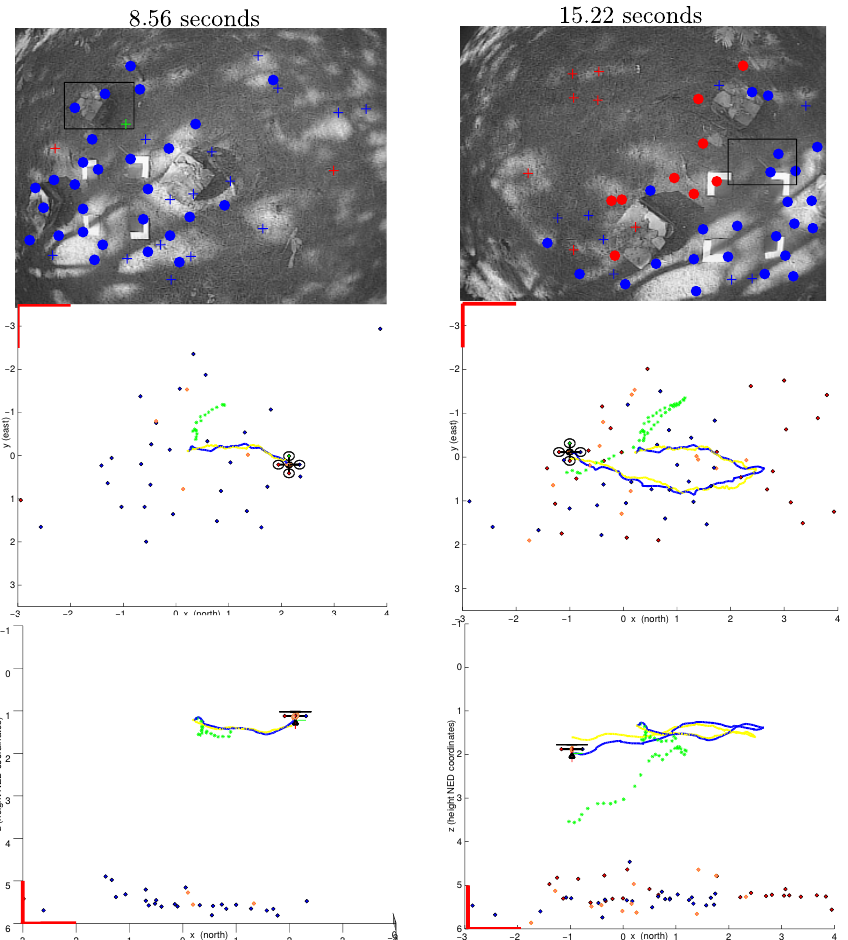
Figure 12. Estimated trajectory and map corresponding to two different instants of time during periods of visual-based navigation: ( upper plots ) real images at 8.56 s and 15.22 s of flight; ( middle plots ) zenital view of maps and estimated trajectories at 8.56 s and 15.22 s of flight; ( lower plots ) sectional view of maps and estimated trajectories at 8.56 s and 15.22 s of flight. The estimated trajectory is indicated in blue. The P4P visual reference is indicated in yellow. GPS position measurements are indicated in green. Comparing visual features with the estimated map, it can be appreciated that the physical structure of the environment is partially